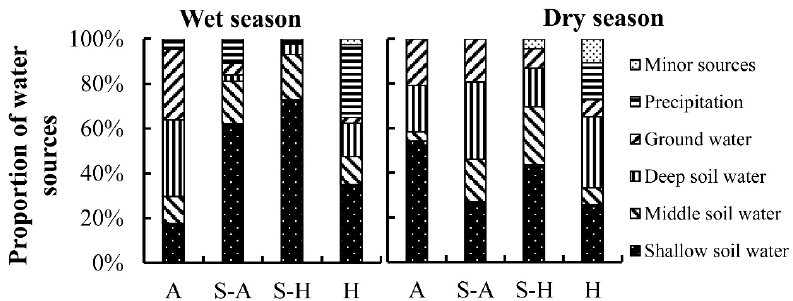
Figure 6. Seasonal changes in the proportion of plant water sources. A: Arid region; S-A: Semi-arid region; S-H: Semi-humid region; H: humid region.